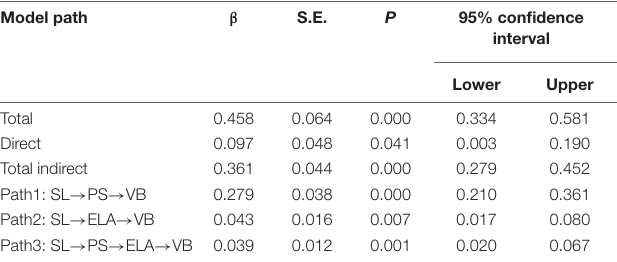
TABLE 4 | Test results of mediating chain effect.